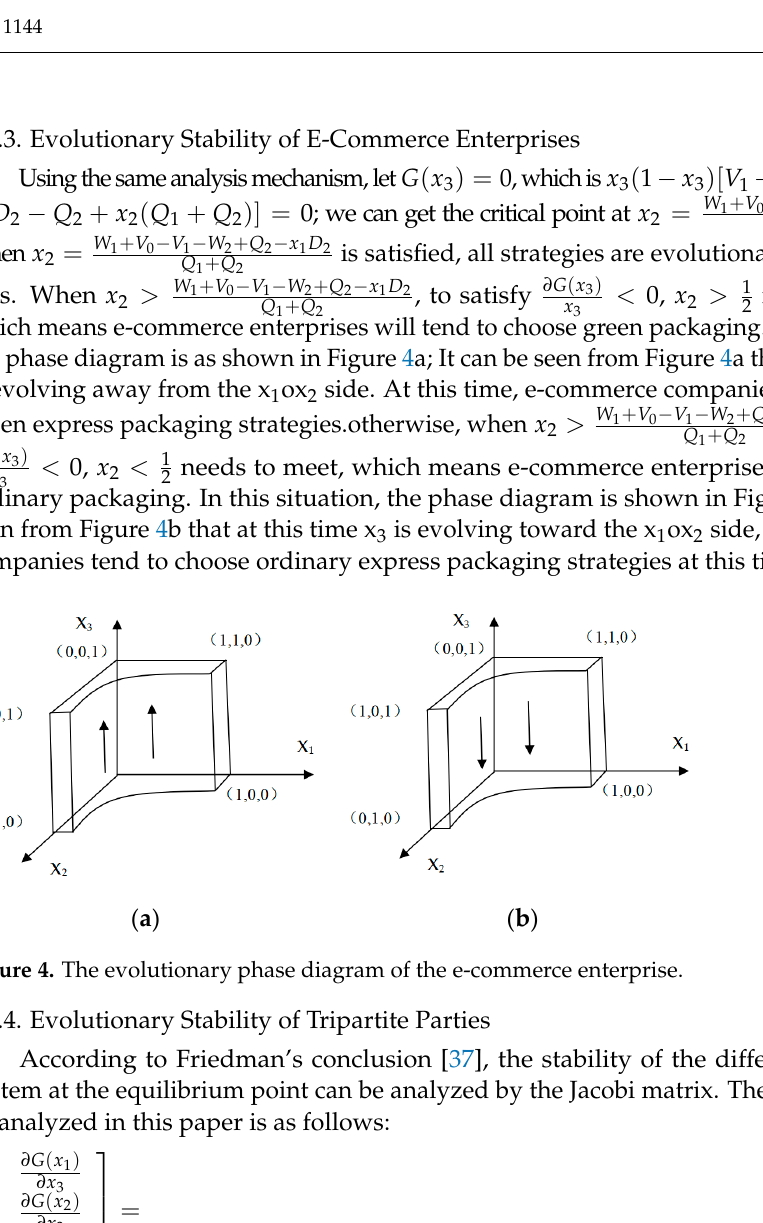
( b ) Figure 3. The evolutionary phase diagram of consumers. 3.3.3. Evolutionary Stability of E ‐ Commerce Enterprises